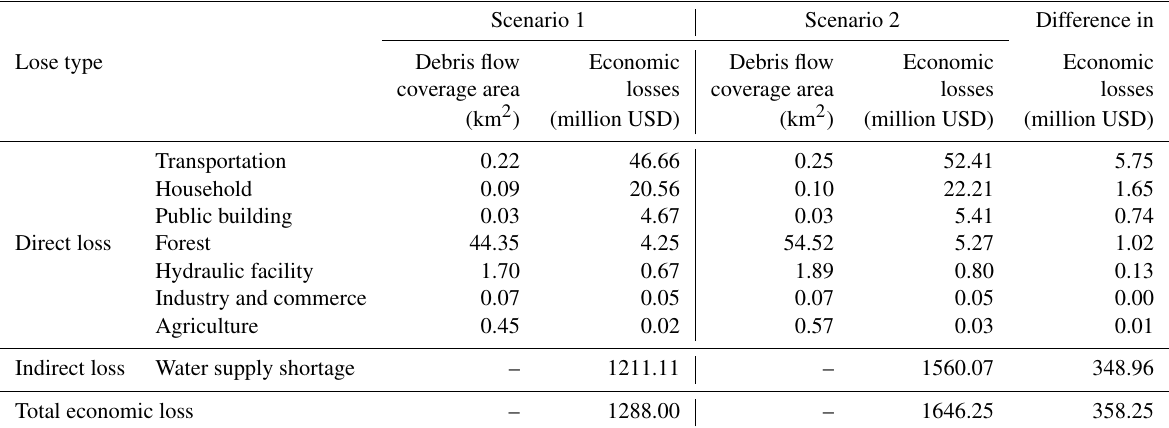
Figure 8. Shallow landslide area simulated by TRIGRS with input soil depth classified by slope angle ( a : scenario 1, b : scenario 2). Table 5. Comparison of economic